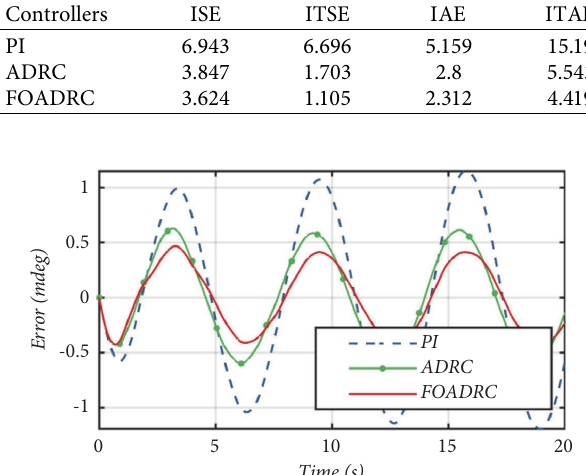
Figure 18: Te error curve of sine input for three controllers.